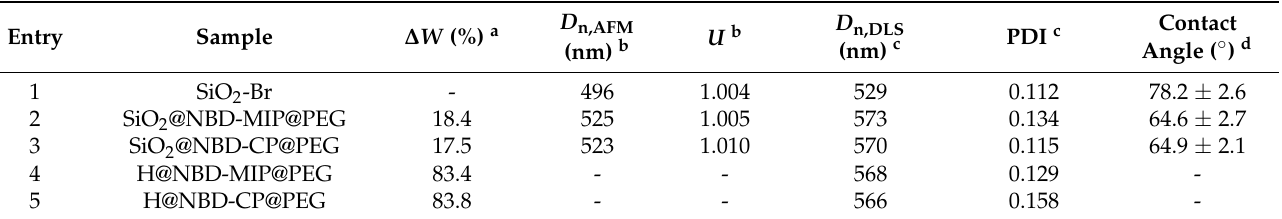
Table 1. Synthetic and characterization data of the “living” silica particles and both the hydrophilic fluorescent solid and hollow HA-MIP/CP